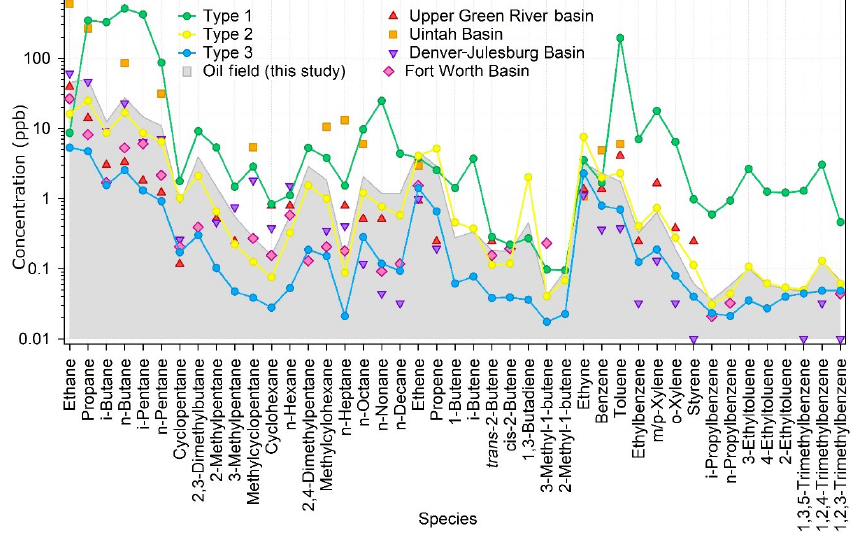
Figure 6. Comparison of the VOC composition of oil field samples (grey area) with three types of ambient samples in this study and in four US oil fields (ERG, 2011; Field et al., 2015; Gilman et al., 2013; Koss et al.,